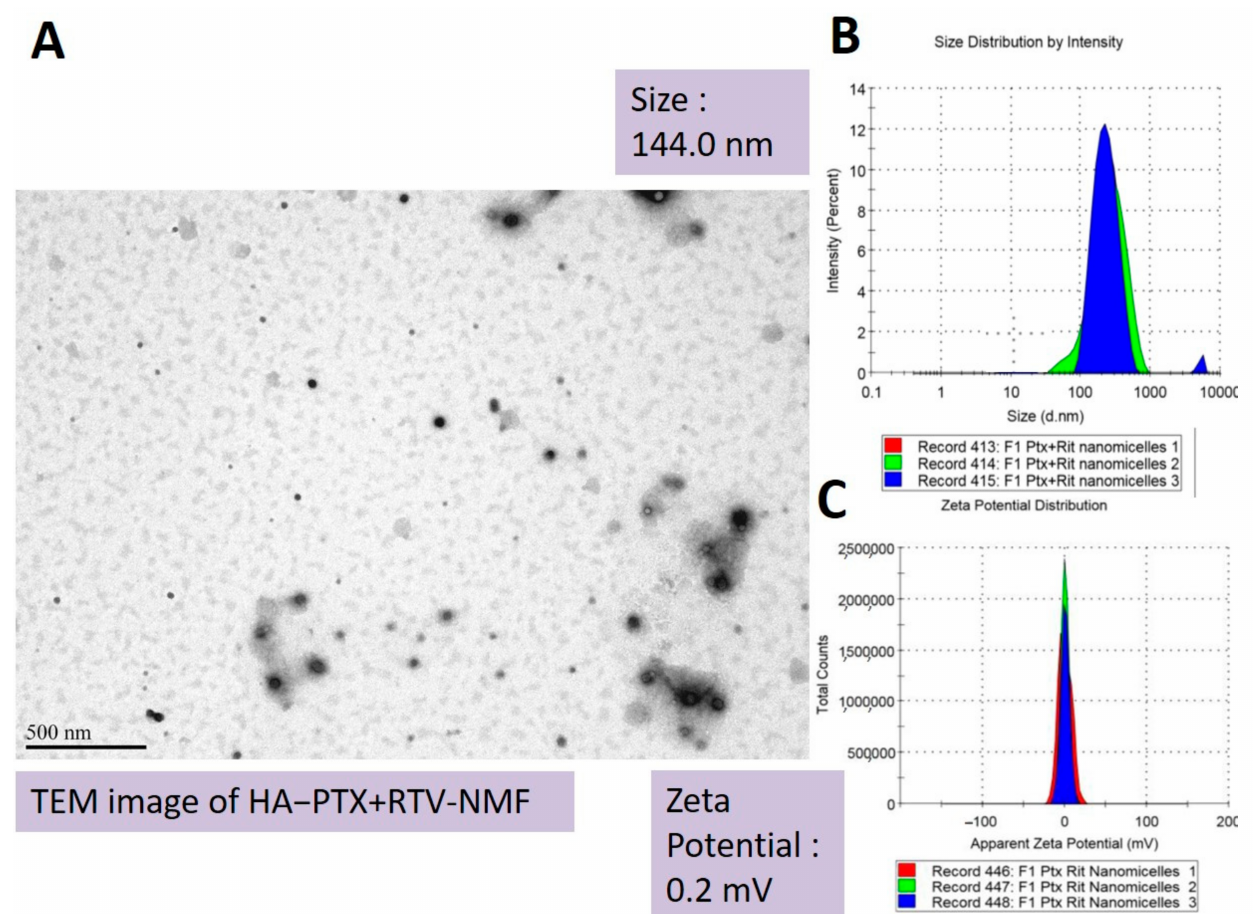
Figure 5. Morphological characteristics for hyaluronic acid targeted paclitaxel and ritonavir nanomicelles (HA − PTX + RTV − NMF). ( A ). Transmission electron microscopy (TEM) image, ( B ) size distribution by intensity (nm), ( C ) and apparent zeta potential (mV) of optimized HA − PTX + RTV −